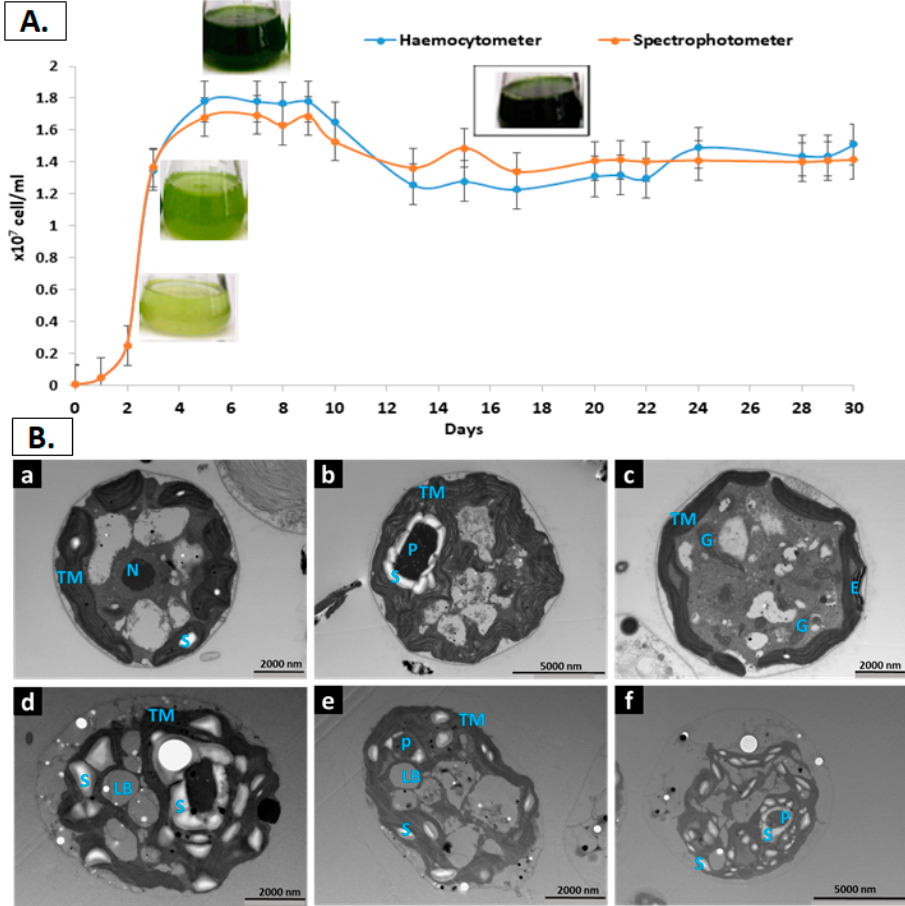
Figure 1. ( A ) Growth curve of C. reinhardtii population grown in mixotrophic condition and measured using either a haemocytometer or spectrophotometer. Data representative of triplicate measurements (SD = 3). ( B ) TEM images of C. reinhardtii grown in TAP and imaged at different time and conditions, a to c are the images of the 14 days old cells while d to f are the images of the 30 days old cells. Letters in blue inside the images refer to the following: P: Pyrenoid; LB: Lipid Bodies; S: Starch granule; TM: Thylakoid Membrane; E: Eyespots; G: Golgi bodies.